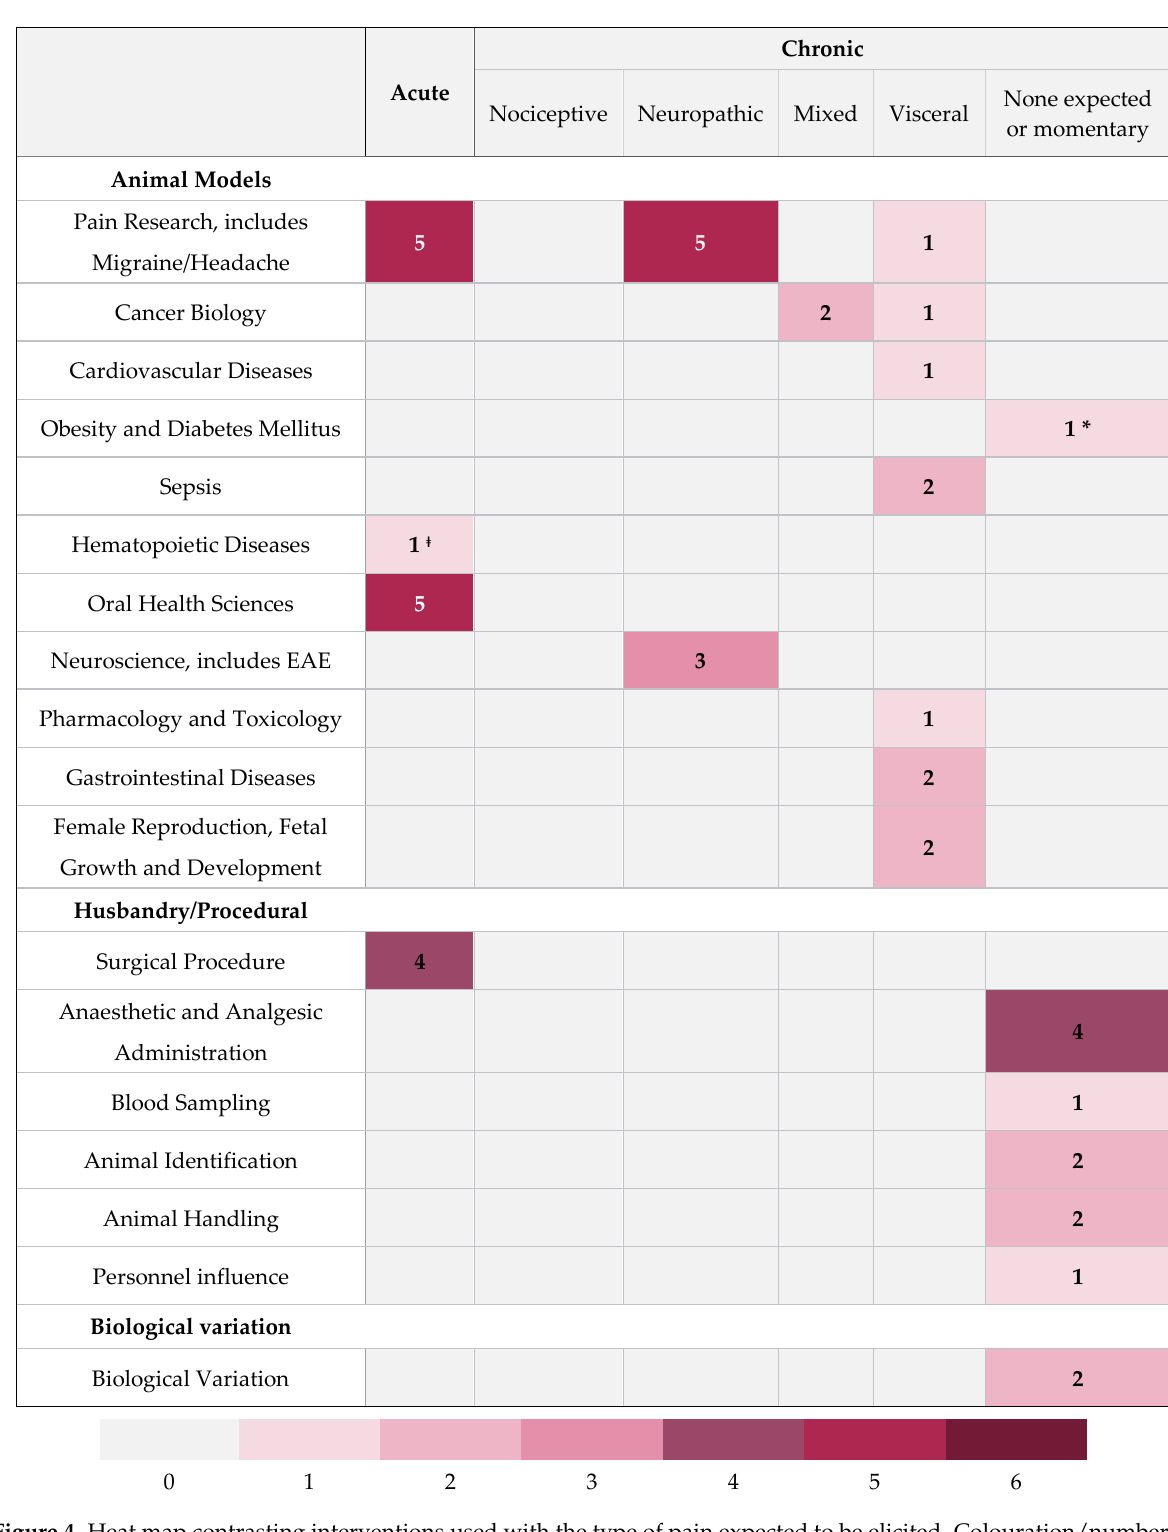
Figure 4. Heat map contrasting interventions used with the type of pain expected to be elicited. Colouration/number in box represents number of studies. Whilst some studies could arguably have been included in multiple categories to simplify reporting, one category has been assigned. ǂ Pain in this study, Mittal et al., 2016 [59], was assigned as acute since it was induced by cold stress, although sickle cell pain can be neuropathic in origin. * Model of Hsi et al., 2020 [45], did not relate to a neuropathy.